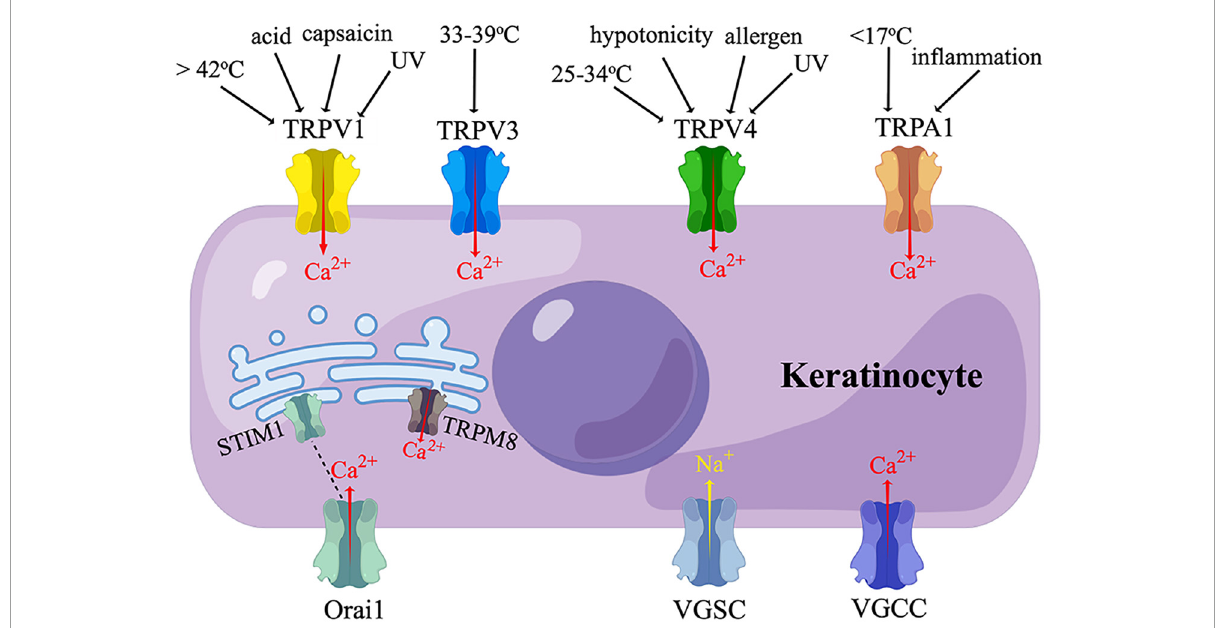
FIGURE2 Sensory receptors expressed on keratinocytes. TRPV, transient receptor potential vanilloid; TRPA, transient receptor potential ankyrin; TRPM, transient receptor potential melastatin; VGSC, voltage-gated sodium channel; VGCC, voltage-gated calcium channel; UV, ultraviolet irradiation. Human keratinocytes express TRPV1, TRPV3, TRPV4, and TRPA1, which are activated by thermal, cold, chemical, or ultraviolet stimuli, and mediate a calcium influx. TRPM8 and STIM1 are temperature-sensitive endoplasmic reticulum transmembrane channels expressed in human keratinocytes. STIM1 is coupled to its plasma membrane subunit, Orail, which also mediate a calcium influx. VGSC and VGCC have also been found in human keratinocytes. (By